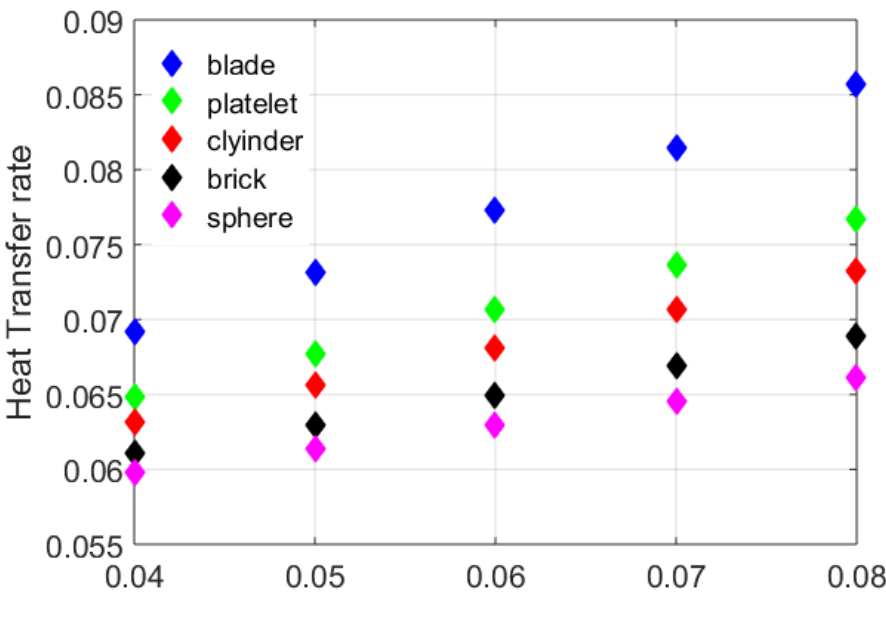
Figure 4. Heat transfer rate for different particle shapes.